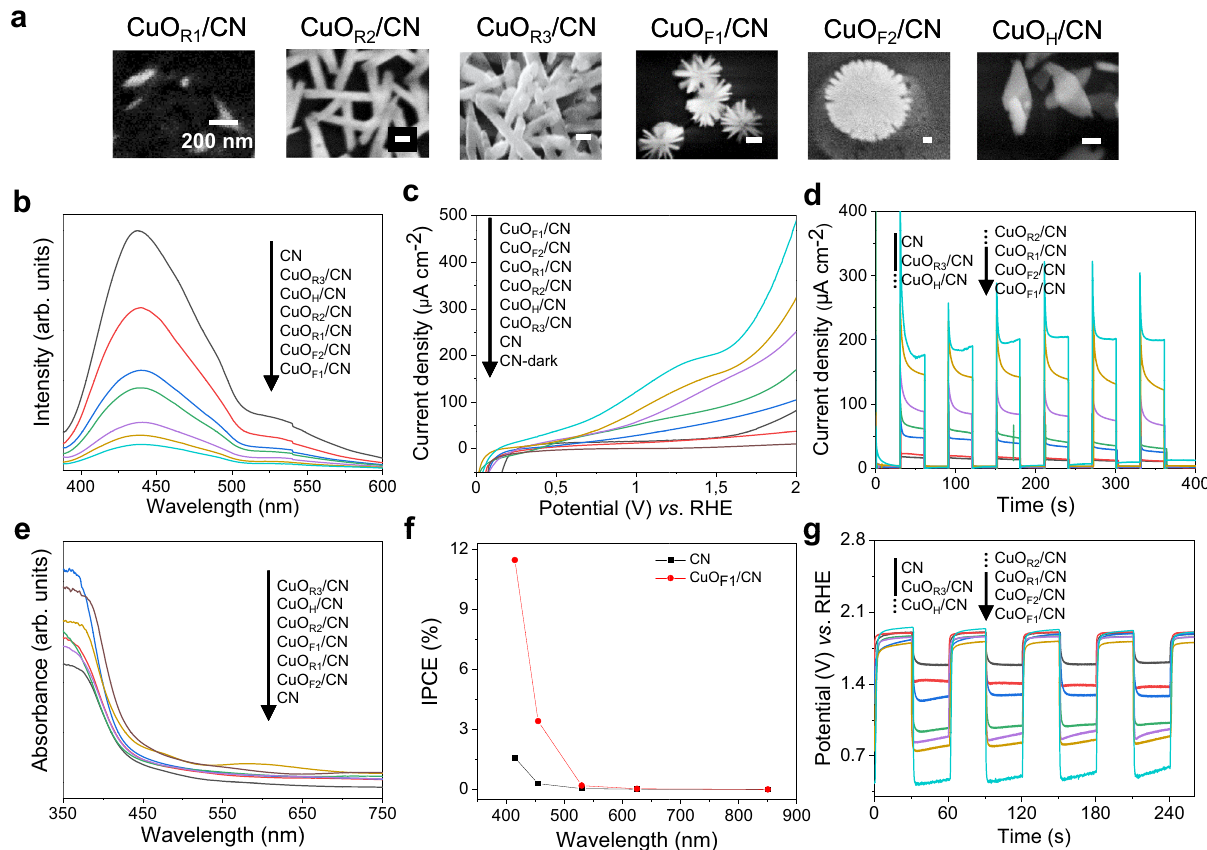
Fig. 5 Photoelectric performance of carbon nitride (CN) and composite electrodes. a Different structures of composite fi lms and their